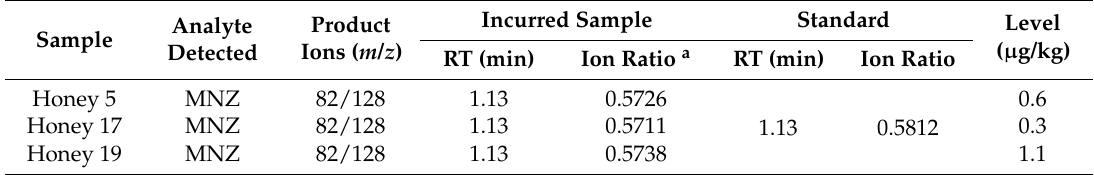
Table 3. Confirmatory and quantitative analysis of honey